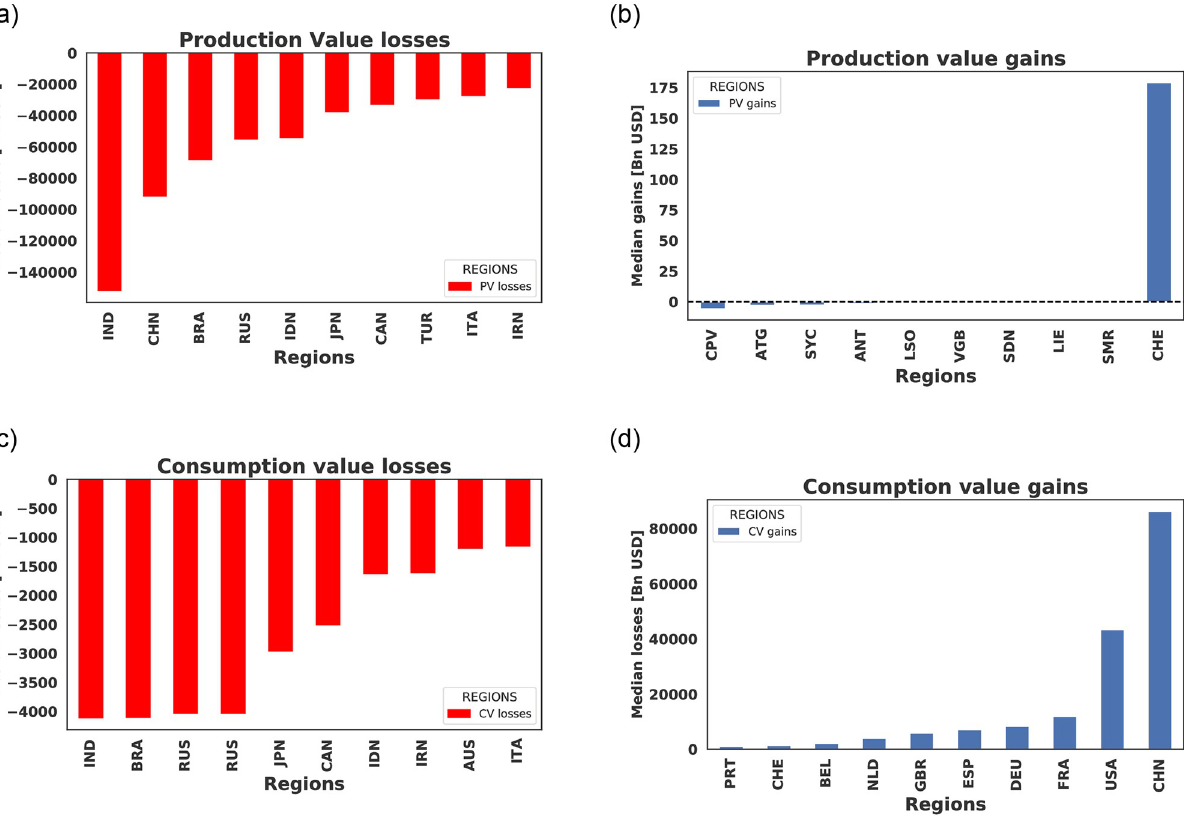
Fig 4. Median production and consumption value losses over all concurrent forcing scenarios. Top 10 countries with most production value losses (a) and least production value losses/gains (b). (c) and (d) are top 10 consumption value losers and gainers respectively. This figure shows that India, Brazil, Russia, Canada Iran are very vulnerable regions. The USA, China, and the EU shows price hikes.